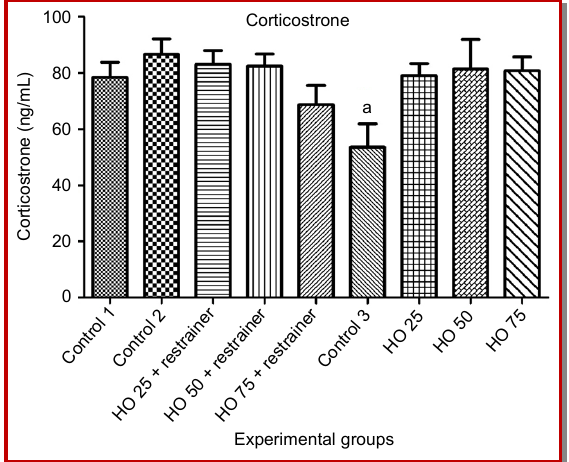
Figure 4: The effect of intraperitoneal injection of different doses of Hyssopus officinalis essential oil on serum corticosterone levels; all groups are compared with control group 1; a significant dif- ference compared to control 1 group (p<0.05); HO: Hyssopus